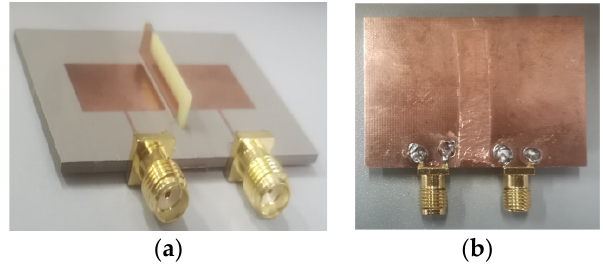
Figure 5. Antenna prototype: ( a ) 3D view and ( b ) back view.